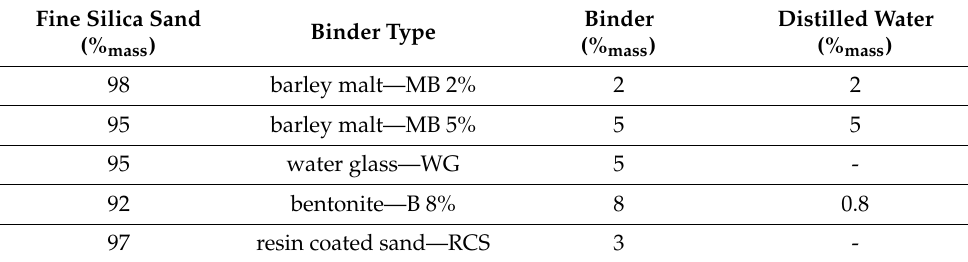
Table 1. Composition of molding sands used in the